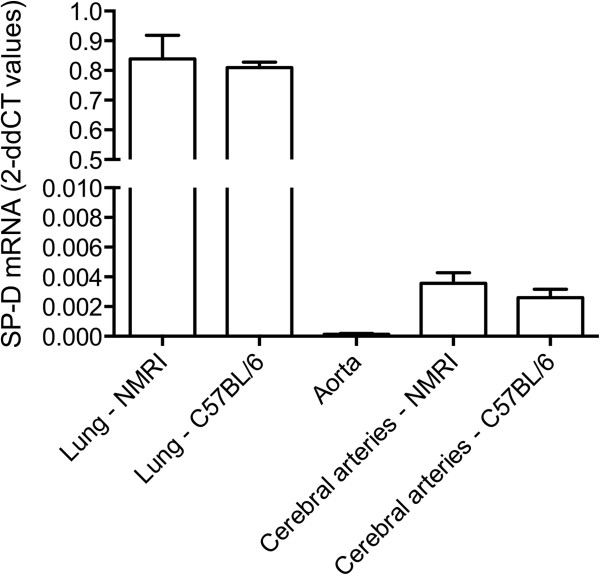
Surfactant protein-D (SP-D) mRNA expression in cerebral arteries. Bargraphs visualizing the difference in expression of SP-D mRNA in dissected cerebral arteries from NMRI and C57BL/6 mice compared to lung tissue and aorta. The expression is given in 2dd-Ct values. Results are expressed as mean ± SD.